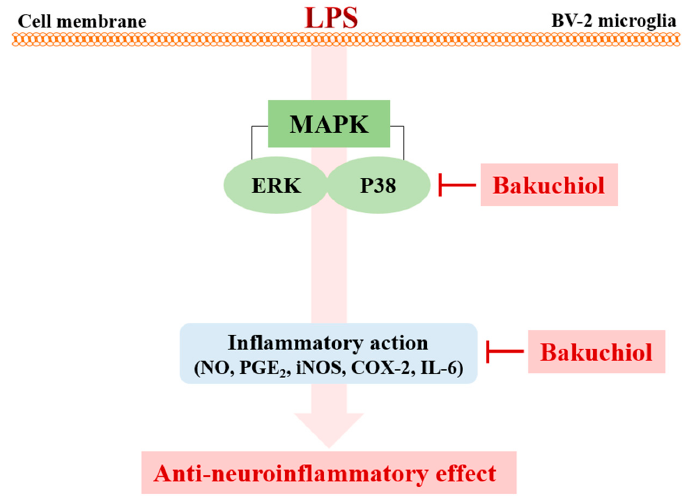
Figure 6. Schematic model of the anti-neuroinflammatory modulation afforded by bakuchiol in activated microglia. Bakuchiol inhibits LPS-stimulated neuroinflammation through the p38 MAPK and ERK signaling pathways.